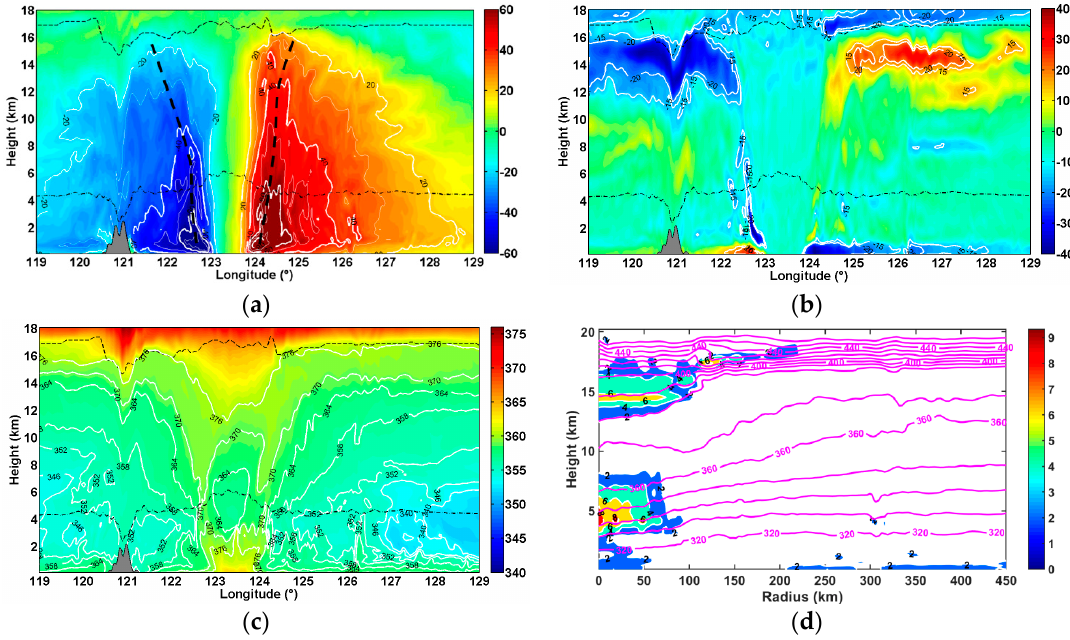
Figure 6. Longitude-height cross sections of simulated ( a ) tangential wind speed (m / s) and isocontours (white) every 10 m / s, ( b ) radial wind speed (m / s) and isocontours (white) of ± 15 and 20 m / s, ( c ) equivalent potential temperature θ e (K) and isocontours (white) every 6 K at the latitude 23 ◦ N on 7 August 12:00 UTC. ( d ) Radial-height cross section of temperature anomalies (color shaded, K) and isocontours (white) every 2 K east of the TC center. Isocontours of potential temperature every 10 K are superimposed (magenta). Horizontal dash-dotted and dashed lines denote the distribution of the freezing level (0 ◦ C isotherm) and the thermal tropopause. Thick vertical dashed lines locate the radius of maximum wind. The orography of Taiwan is shaded